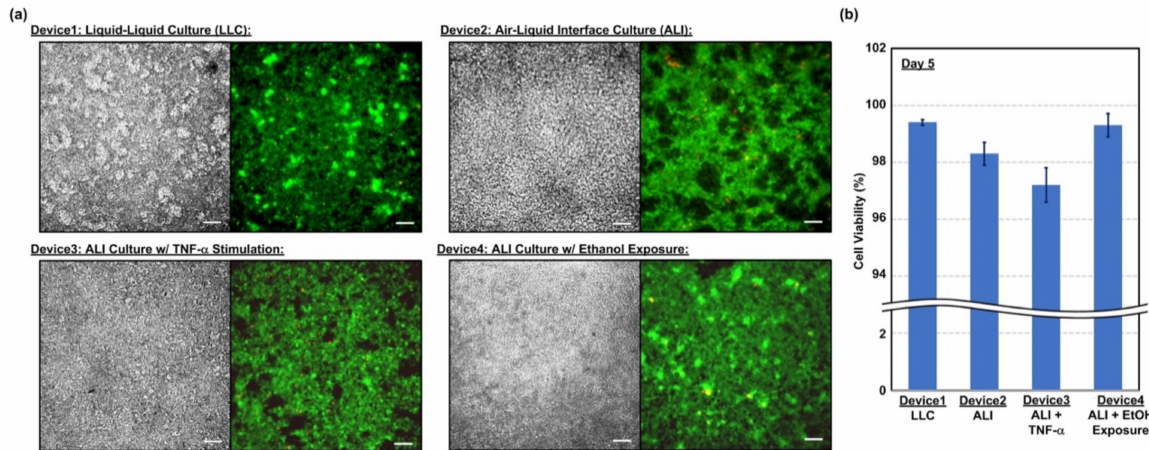
Figure 4. ( a ) Brightfield phase images and the fluorescence images of the hAELVi cells cultured in the devices for 5 days and under different conditions from Day 2 to 5. Scale bar is 20 µ m. ( b ) The quantitative analysis results of the cell viability assay at Day 5.